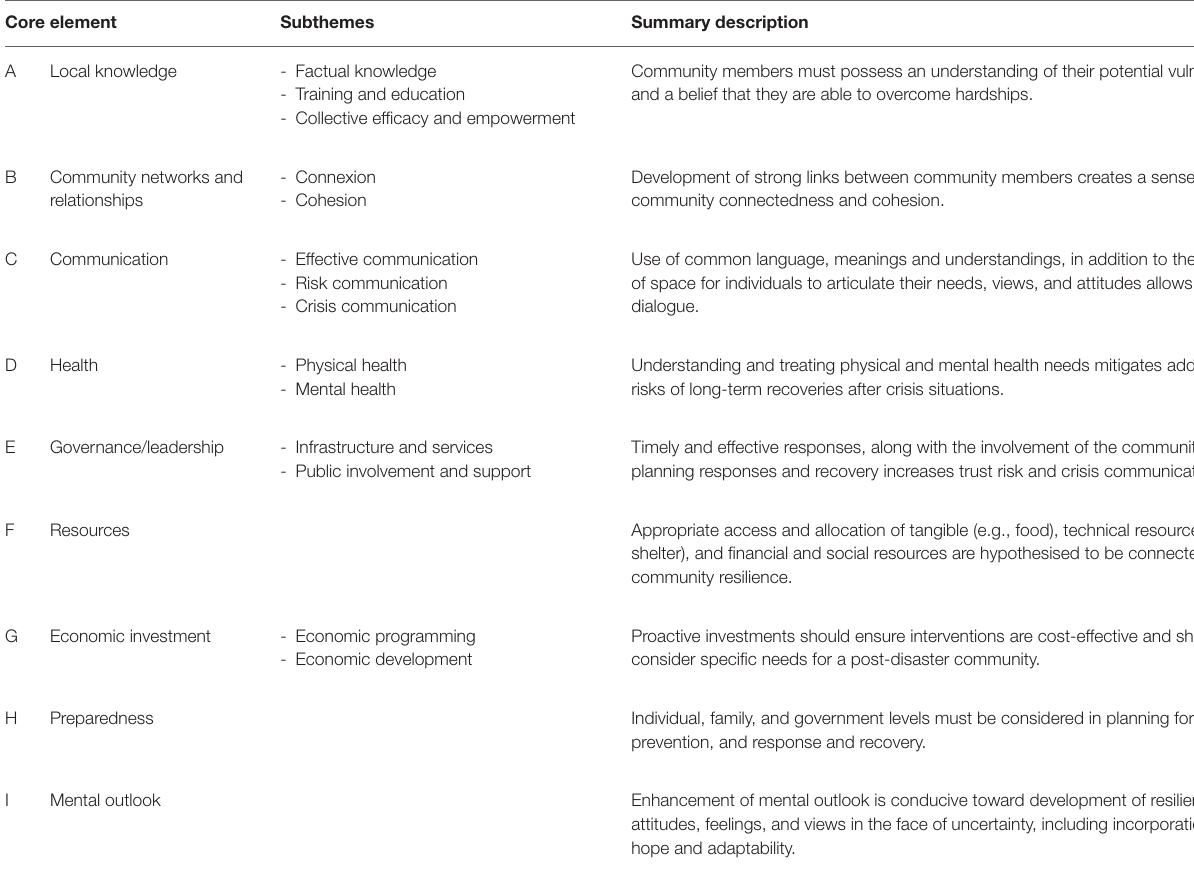
TABLE 2 | Elements of community resilience as proposed by Patel et al. (12). Core element Summary